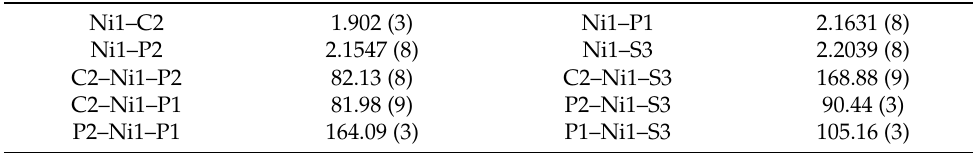
Table 3. Selected geometric parameters (Å, ◦ ) for ( 3